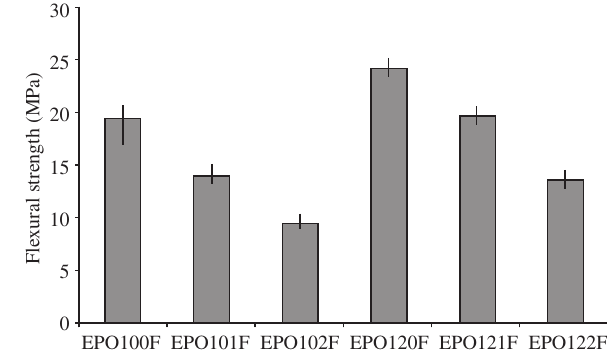
Figure 4. Flexural strength comparison of all polymer concrete formula-